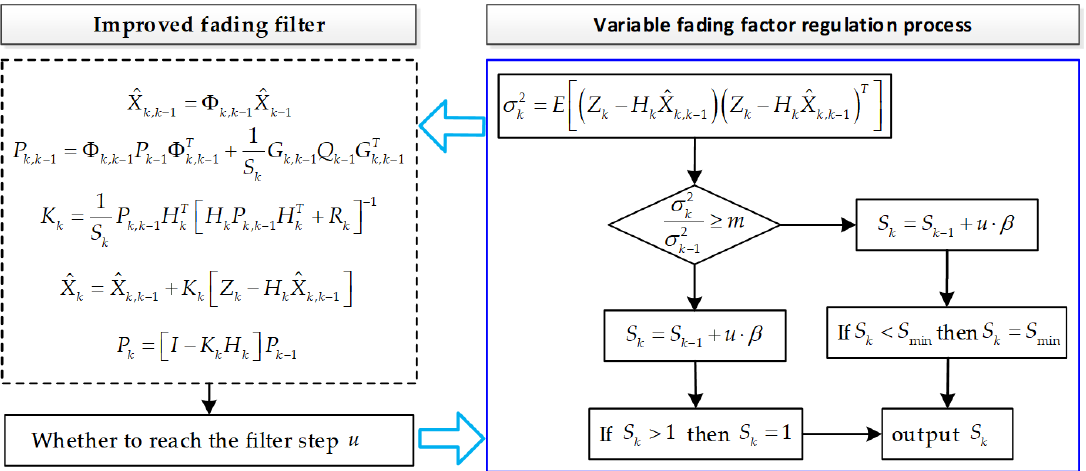
Figure 2. Flow chart of the proposed improved fading filter algorithm.